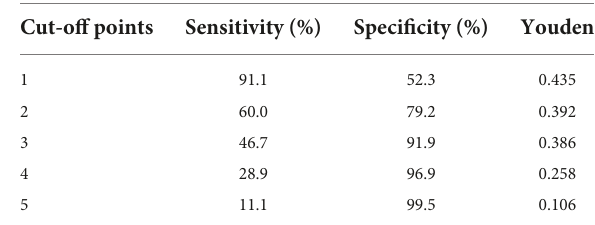
TABLE 4 Sensitivity and specificity according to different cut-off values for 28-day